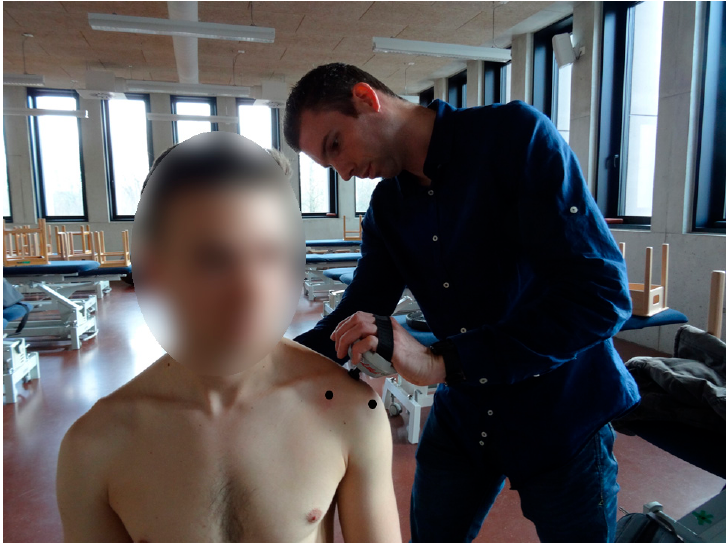
Figure 1. Pressure applied to the acromioclavicular joint, with the other areas marked with a black